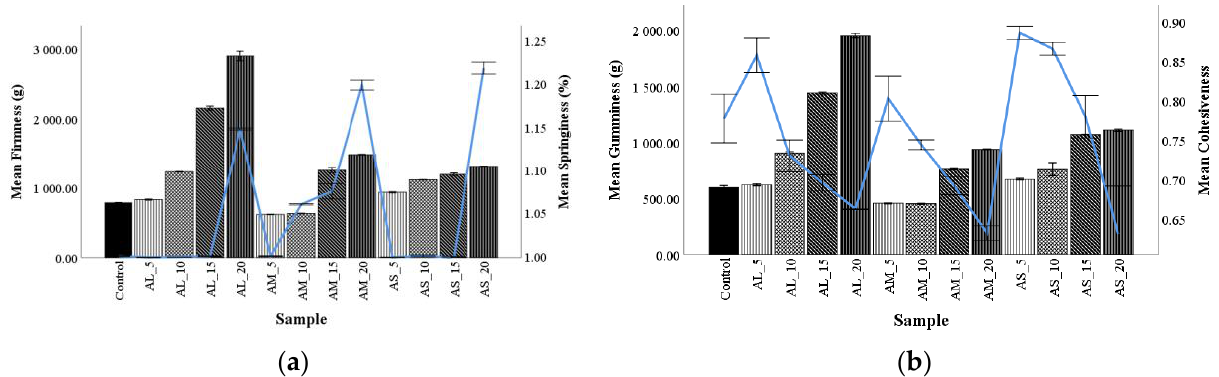
Figure 2. The effect of amaranth flour of large (AL), medium (AM), and small (AS) particle sizes added at 5%, 10%, 15%, and 20% on bread texture parameters: ( a ) firmness and springiness and ( b ) gumminess and cohesiveness compared with the